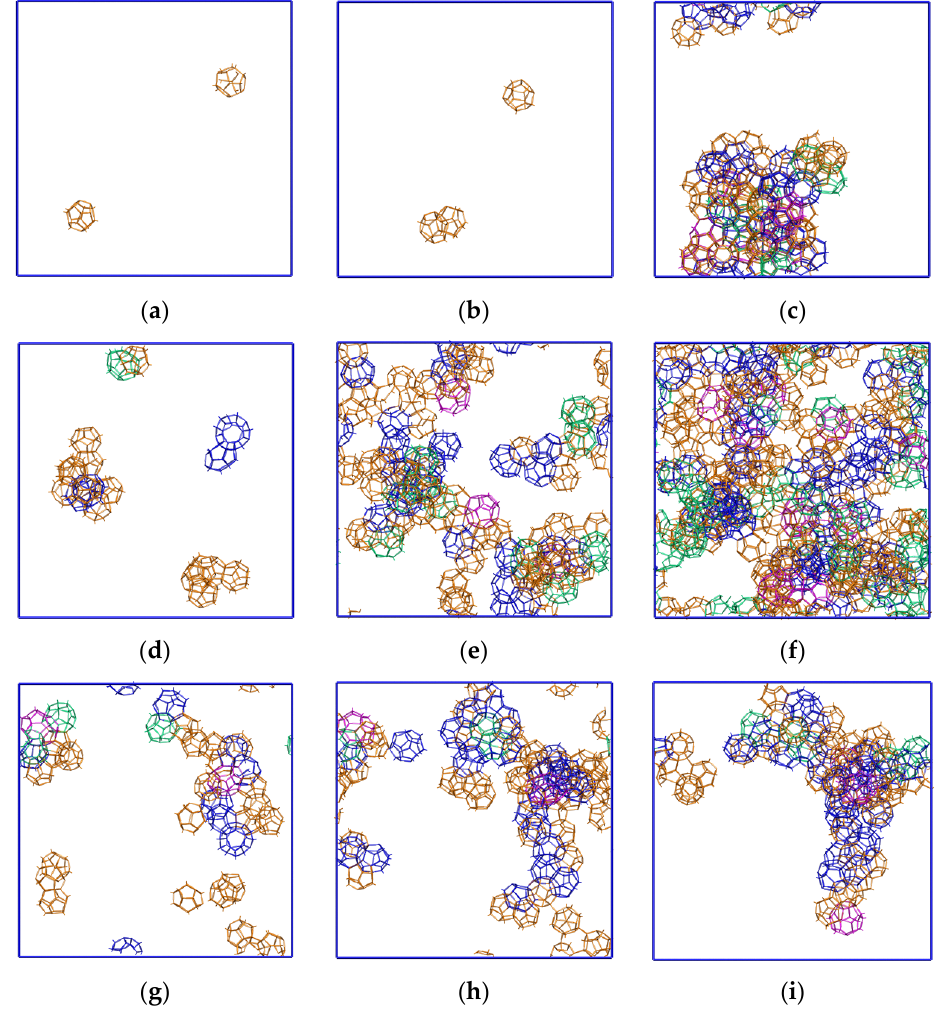
Figure 7. Spatial distribution of 5 12 ( orange ), 5 12 6 2 ( blue ), 5 12 6 3 ( green ), and 5 12 6 4 ( magenta ) cavities for ( a – c ) C = 0.4, ( d – f ) C = 0.6, and ( g – i ) C = 0.8 systems at simulation time points: 20 ns, 40 ns, and 100 ns. Hydrate-like structure growth at a concentration of 0.8 is not characteristic; the drawing angle is the same as in Figure 5.